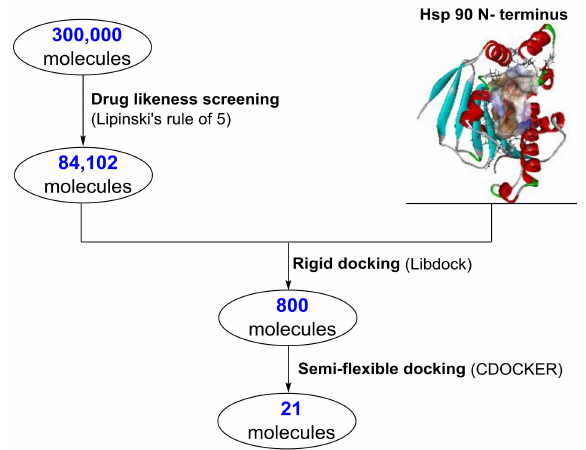
Figure 2. Workflow of the virtual screening protocol for Hsp90 inhibitor development.